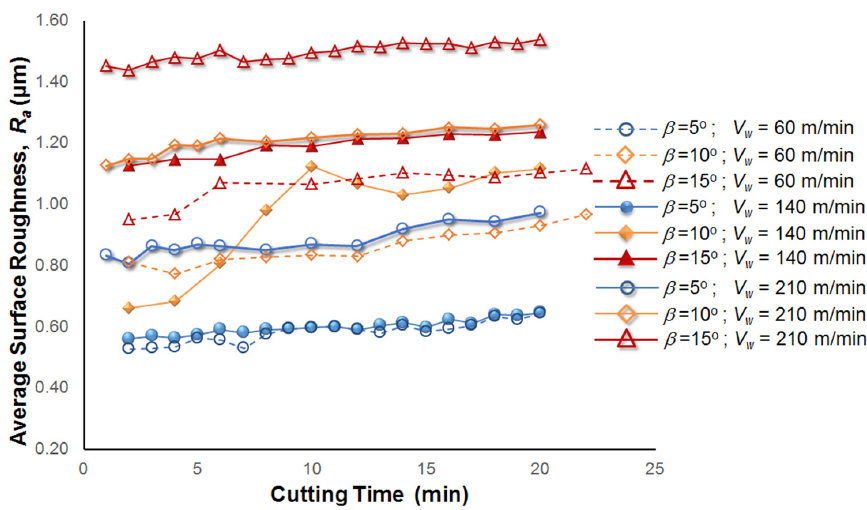
11 of 18 Figure 7. The chips adhered on the cutting edge of a round tool. 4.1.2. Effect of Tool Inclination Angle Based on the qualitative testing, the surface roughness was increased by increasing the tool inclination angle (see Figure 8). It can be seen from this figure that the average surface roughness value obtained was about 0.58 mm at the tool inclination angle ( β ) of 5 deg., cutting speed ( V w ) of 60 m/min, and round tool diameter ( d t ) of 16 mm. When the inclination angle was increased to 10 deg., the average surface roughness value obtained was higher than that obtained at the tool inclination angle of 5 deg., which is about 0.86 mm. An increase in the average surface roughness value was also obtained, which was